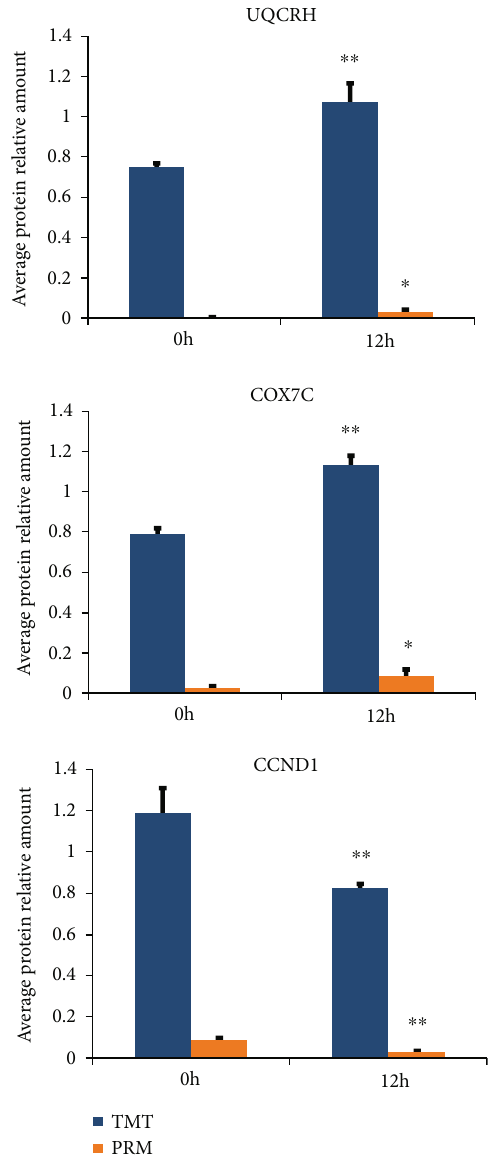
Figure 6: Expressions of UQCRH, COX7C, and CCND1 were analyzed by TMT and PRM. When hBMSCs were hypoxia- induced for 12 hours, expressions of UQCRH and COX7C were upregulated, while that of CCND1 was downregulated in TMT and PRM analyses. Mean ± SD . ∗ p < 0 : 05 and ∗∗ p < 0 : 01 vs. the 0h control group. Experiments were performed in three hBMSC cultures from three di ff erent